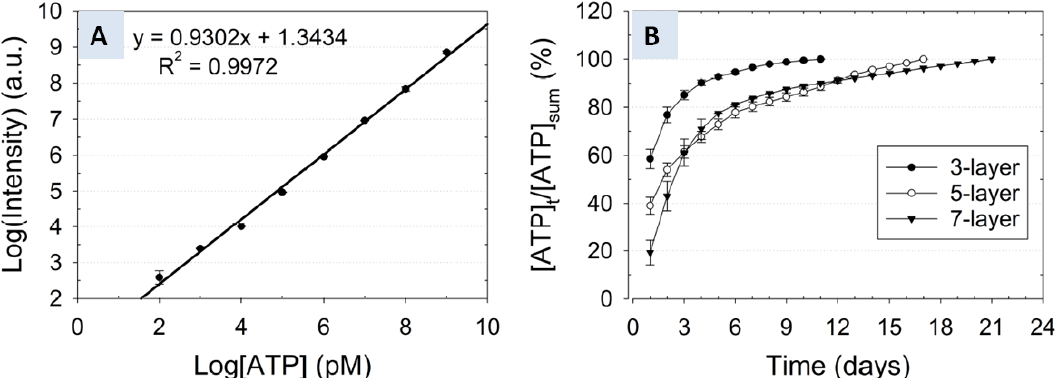
Figure 3. ATP release from cumulative layers of multilayer meshes: ( A ) Standard curve of ATP concentration vs. luminescence intensity; ( B ) Cumulative release profile of ATP from a three-layer nanofiber-hydrogel mesh ( ); Cumulative release profile of ATP from a five-layer nanofiber-hydrogel mesh ( ); Cumulative release profile of ATP from a seven-layer nanofiber-hydrogel mesh (